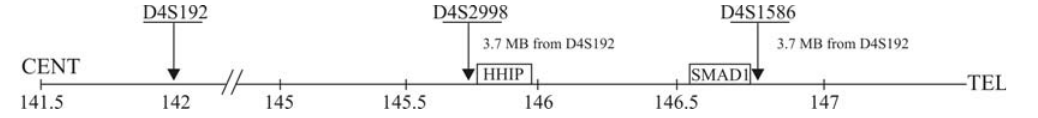
Figure1 -Schematicrepresentationofthepositionofthemicrosatellitemarkersanalyzedinthisstudyinrelationtocandidategenes HHIP and SMAD. In ascaleofmegabases,theboxesindicatethepositionofthegeneswithinthe4q31regionandthearrowsindicatetheD4S2998andD4S1586microsatellite position. In addition the position of marker D4S192 is indicated. For each gene their distance relative to D4S192 is indicated. See text for the distance of microsatellite markers relative to the candidate